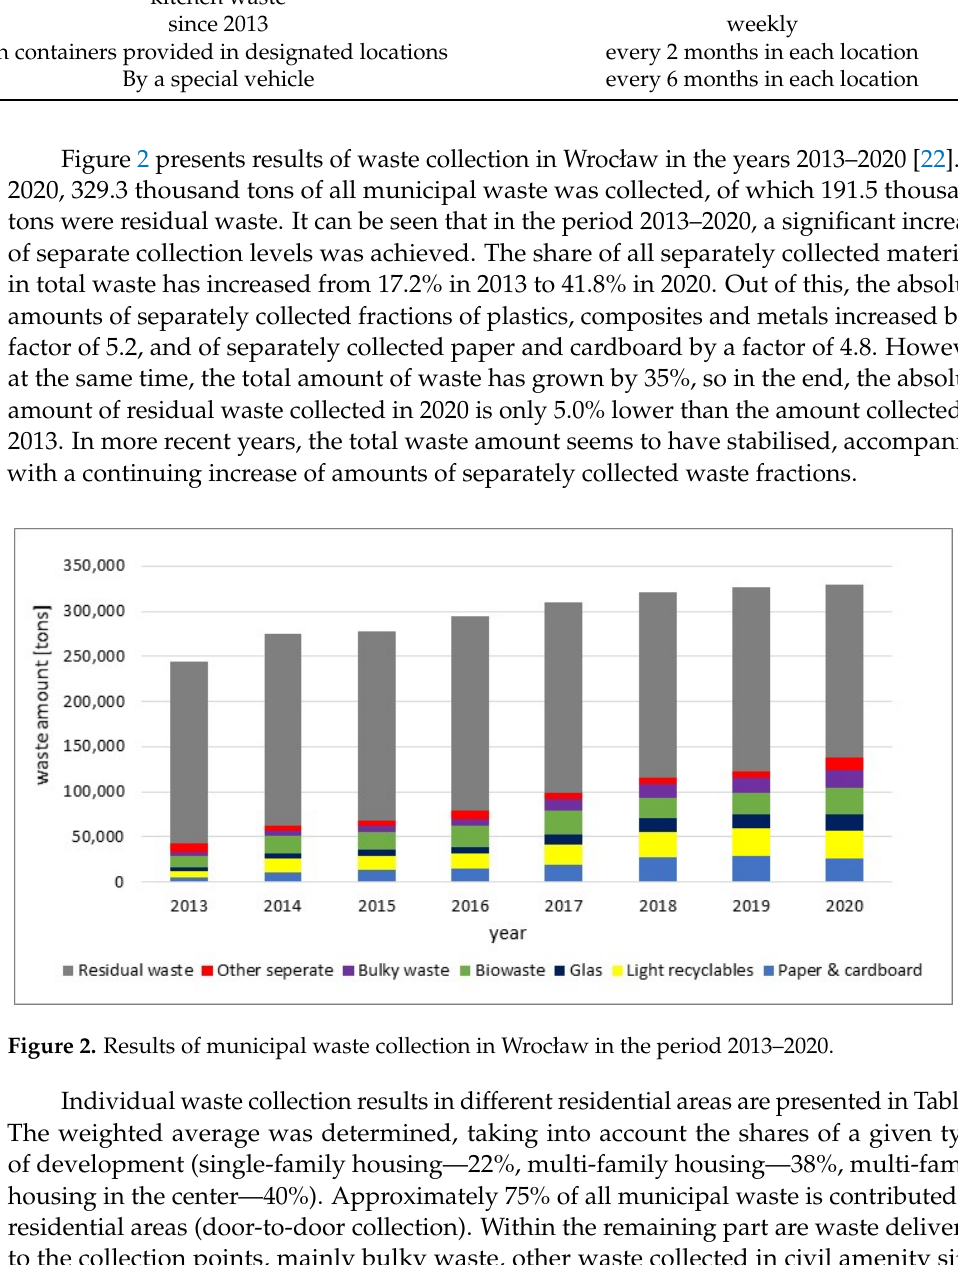
Table 2. Individual waste collection rates for different types of housing [kg per capita and year].